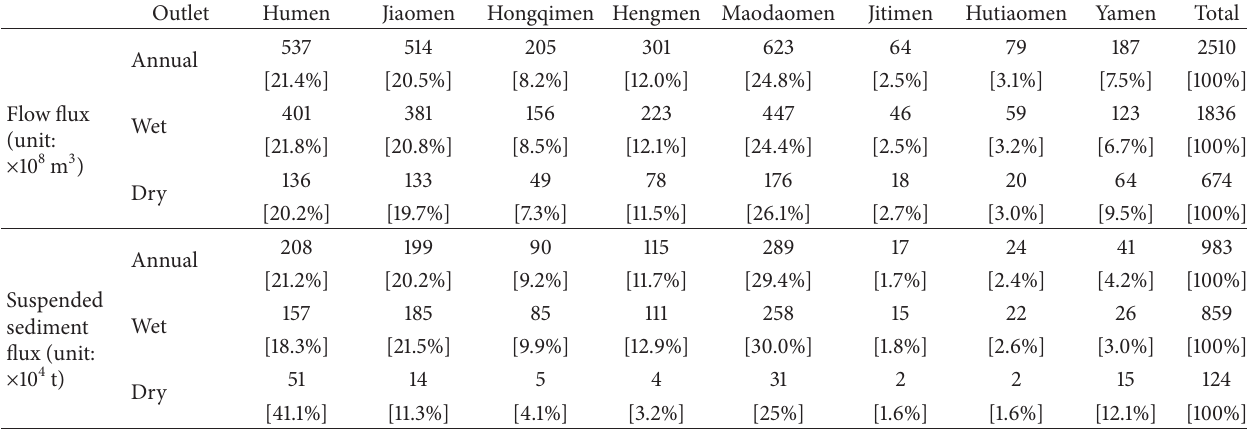
Table 4: The simulated flow flux and suspended sediment flux at the eight outlets in